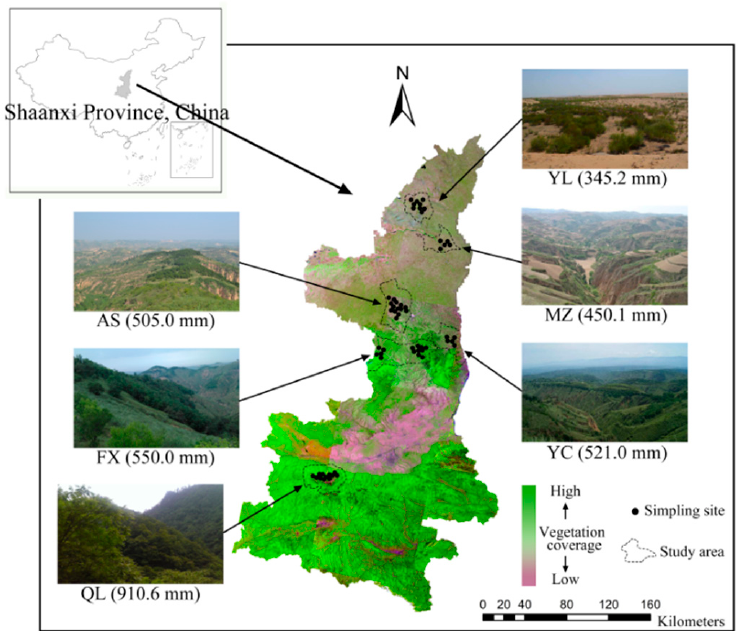
Figure 1. Variability of vegetation coverage in the study area, and location and general view of the experimental field sites.